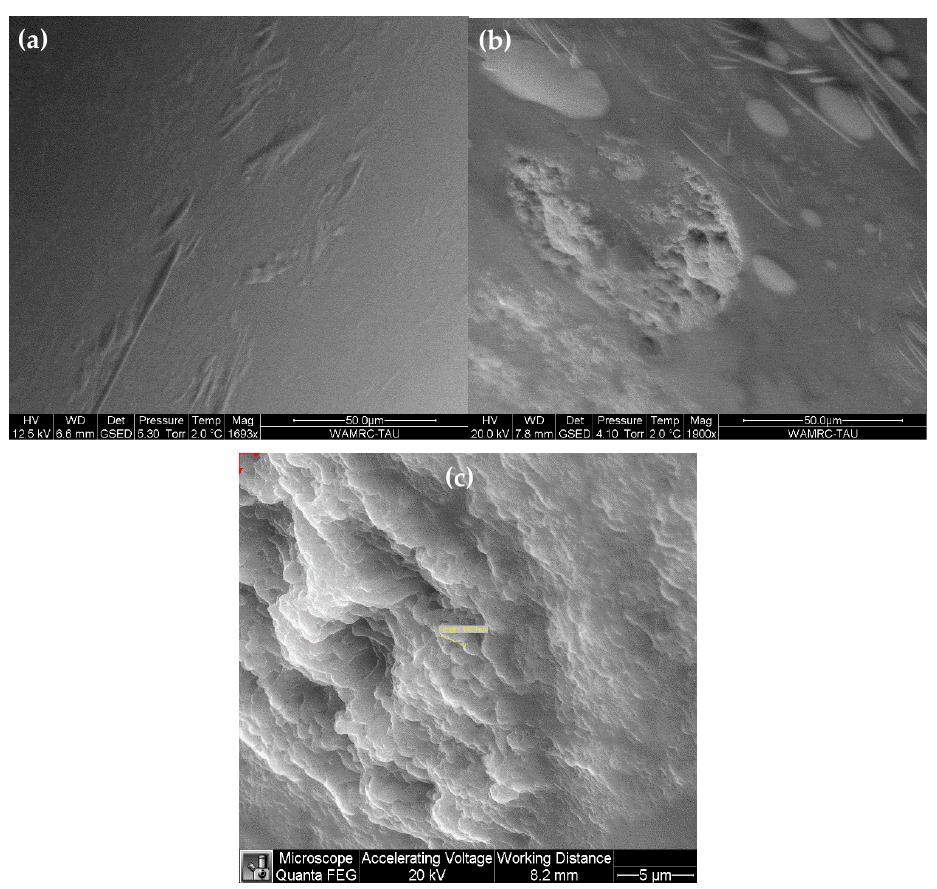
Figure 9. ESEM images revealing the surface morphology of: ( a ) epoxy LY 5052 droplets in the absence of bacteria; ( b , c ) epoxy LY 5052 droplets in the presence of bacteria, at two different magnifications.